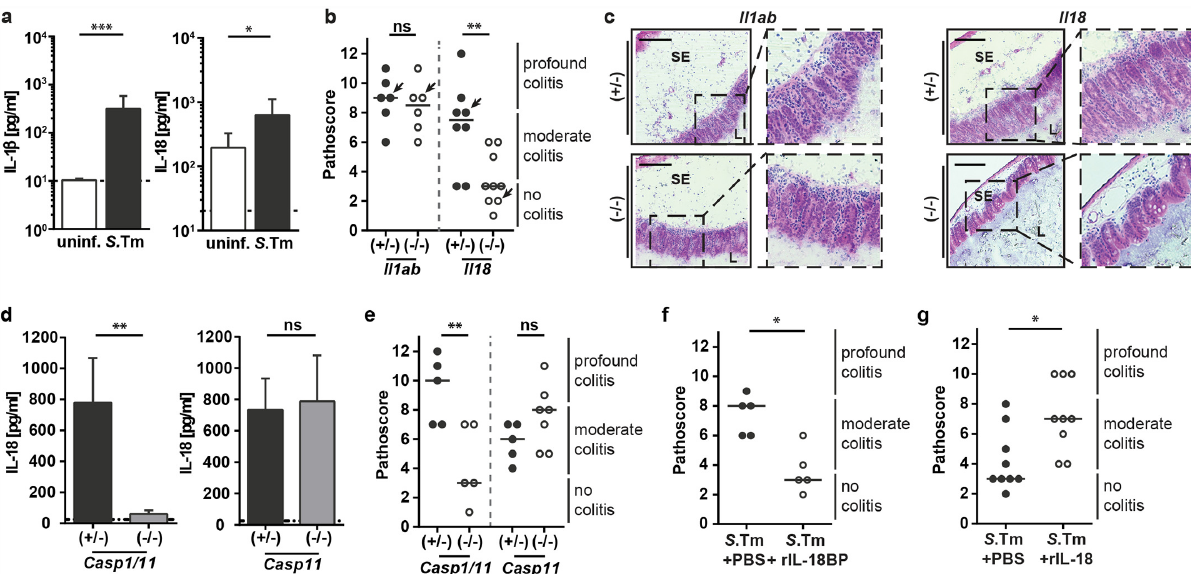
Fig 1. IL-18 modulates the onset of S .Tm-induced intestinal inflammation. (a) Mature IL-1 β and IL-18 protein levels were measured in whole cecum tissue homogenates from C57BL/6 WT mice. Mice were Sm-pretreated and remained uninfected or were infected orally with 5x10 7 CFU S.Tm for 12h (n = 7 per group); dashed lines indicate the detection limit. (b and c) Il1ab -/- and Il18 -/- mice and littermate controls were Sm-pretreated and infected orally with 5x10 7 CFU S .Tm for 12h (n = 6 – 9 per group). (b) pathological score; arrows indicate representative mice depicted in panel c, (c) HE-stained cryosections from representative mice of each group; SE = submucosal edema, L = lumen; scale bar = 100 μ m; left panel: Il1ab -/- , right panel: Il18 -/- . (d and e) Casp1/11 -/- and Casp11 -/- mice and littermate controls were Sm-pretreated and infected orally with 5x10 7 CFU S .Tm for 12h (n = 5 – 7 per group). (d) Mature IL-18 protein levels in whole cecum tissue lysates from Casp1/11 -/- or Casp11 -/- mice and littermate controls; dashed lines indicate the detection limit. (e) Pathological score. (f) C57BL/6 WT mice were Sm-pretreated, injected intraperitoneally with rIL-18BP or PBS, infected orally with 5x10 7 CFU S .Tm for 12h (n = 5 per group) and mucosal inflammation was quantified. (g) C57BL/6 WT mice were Sm-pretreated, injected intraperitoneally with rIL18 or PBS, infected orally with 5x10 7 CFU S .Tm for 8h (n = 9 per group) and mucosal inflammation was quantified. Data represent the mean ± SD and statistical analysis was performed using the Mann-Whitney-U test (ns = not significant, * : p < 0.05; ** : p < 0.01; *** : p < 0.001).